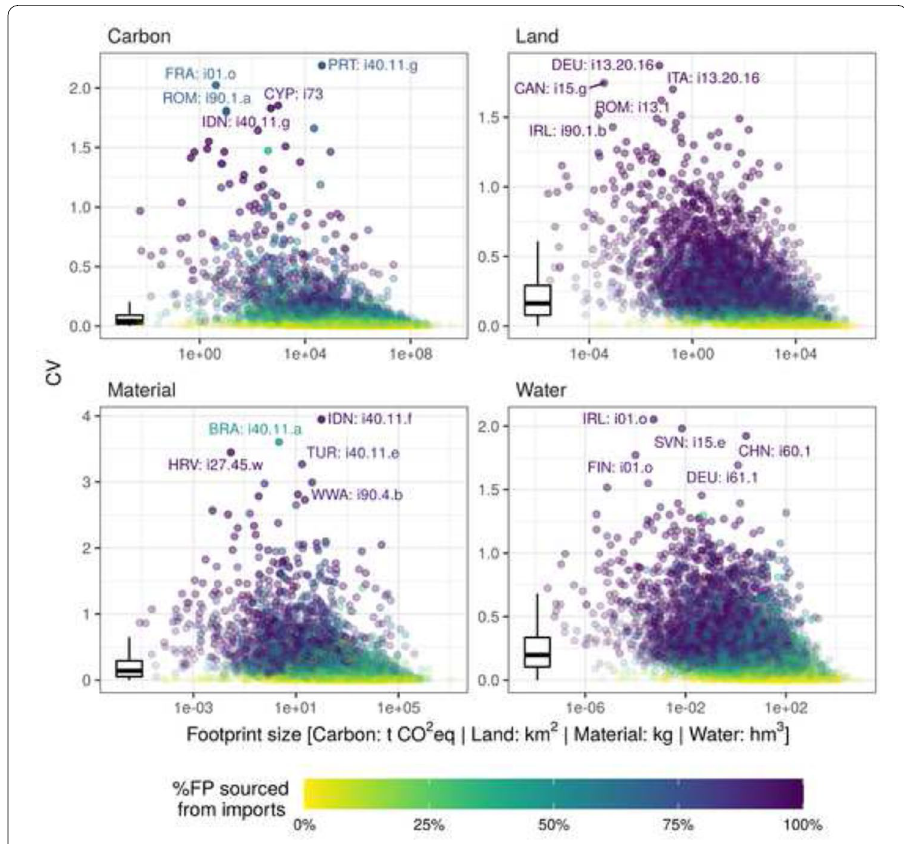
Fig. 5 The relative variability (CV) of the industry footprints compared to their absolute size assuming proportional import shares. The 10 industries with the smallest non-zero footprint and all industries with a zero footprint are not shown. Boxplots show the distributions of the CVs across all industries with a non-zero footprint to facilitate comparison between the different types of